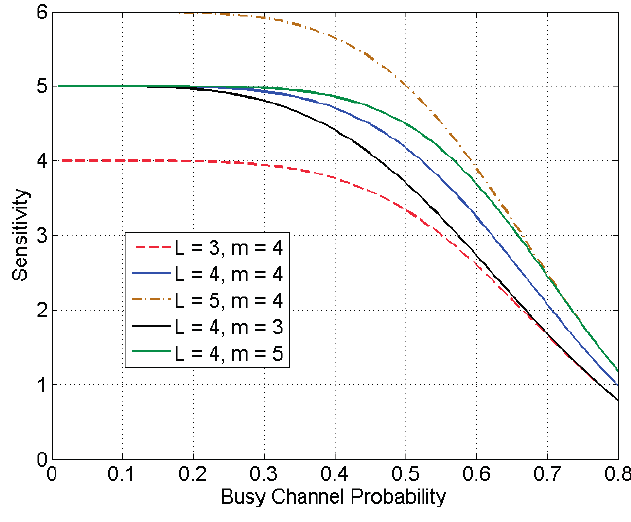
Figure 2. Sensitivity with respect to busy channel